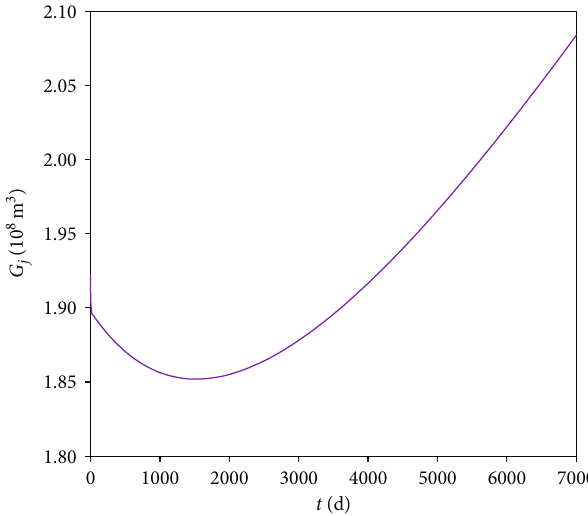
Figure 9: The estimated pro fi le of gas reserves ( G